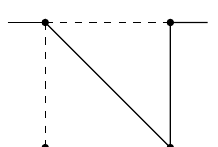
Figure 2 . The graph associated with the master integral which we evaluate in terms of elliptic